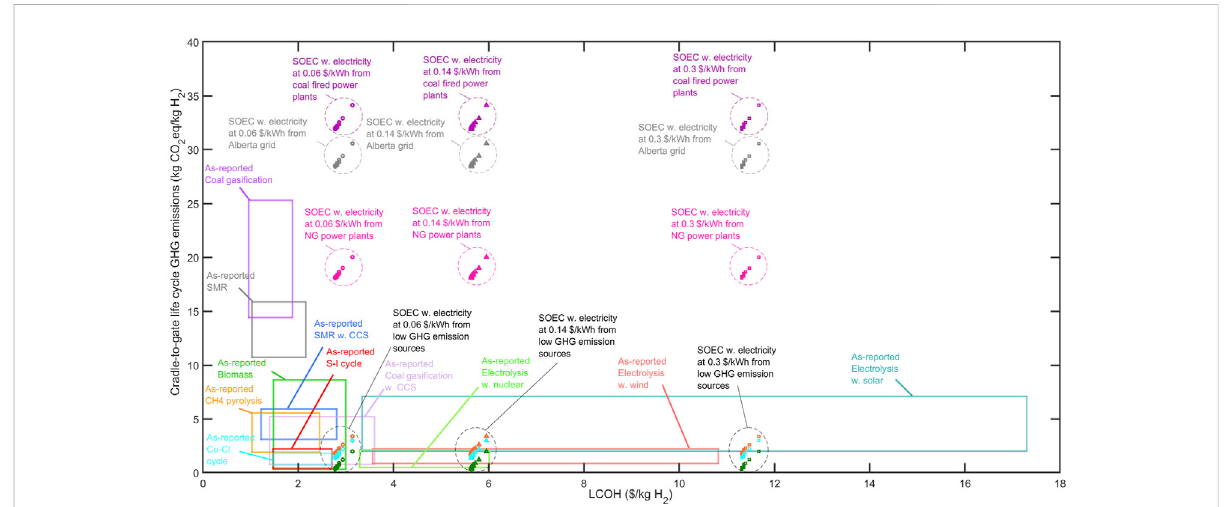
FIGURE 11 Life cycle GHG emissions of various hydrogen-production methodologies versus their LCOH. The boxes show as-reported data ranges collected by Parkinson et al. (2019) Scatter points have been calculated for SOECs in this study. Marker types indicate the electricity price. Circles, squares, and triangles indicate electricity at 0.06, 0.14, and 0.30 $/kWh, respectively. Points colors specify the supplied electricity source as follows: Coal power plant, Alberta grid, NG power plant, Ontario grid, Nuclear power, Quebec